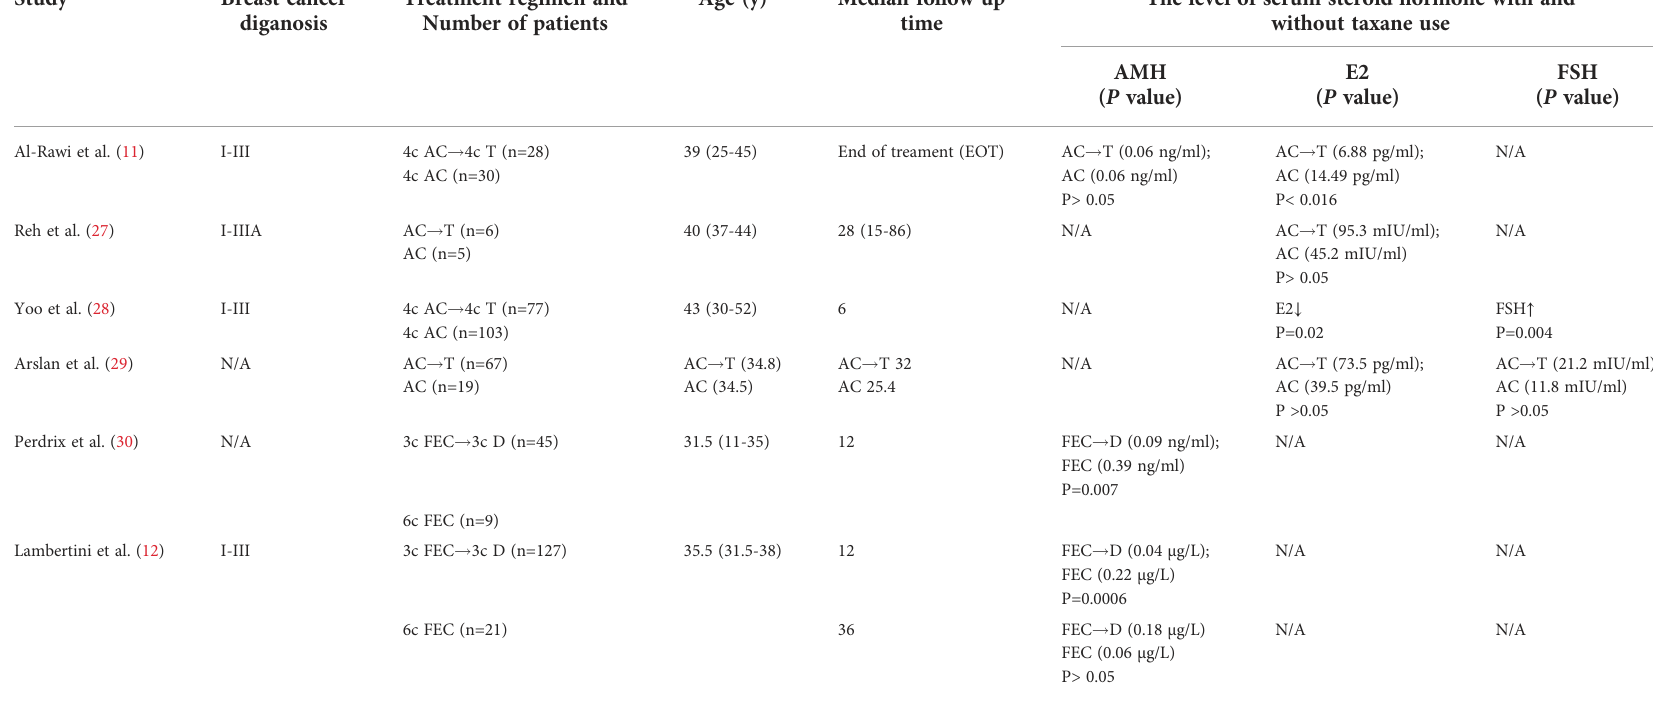
TABLE 1 The changes of female hormone levels with taxane-based chemotherapy.